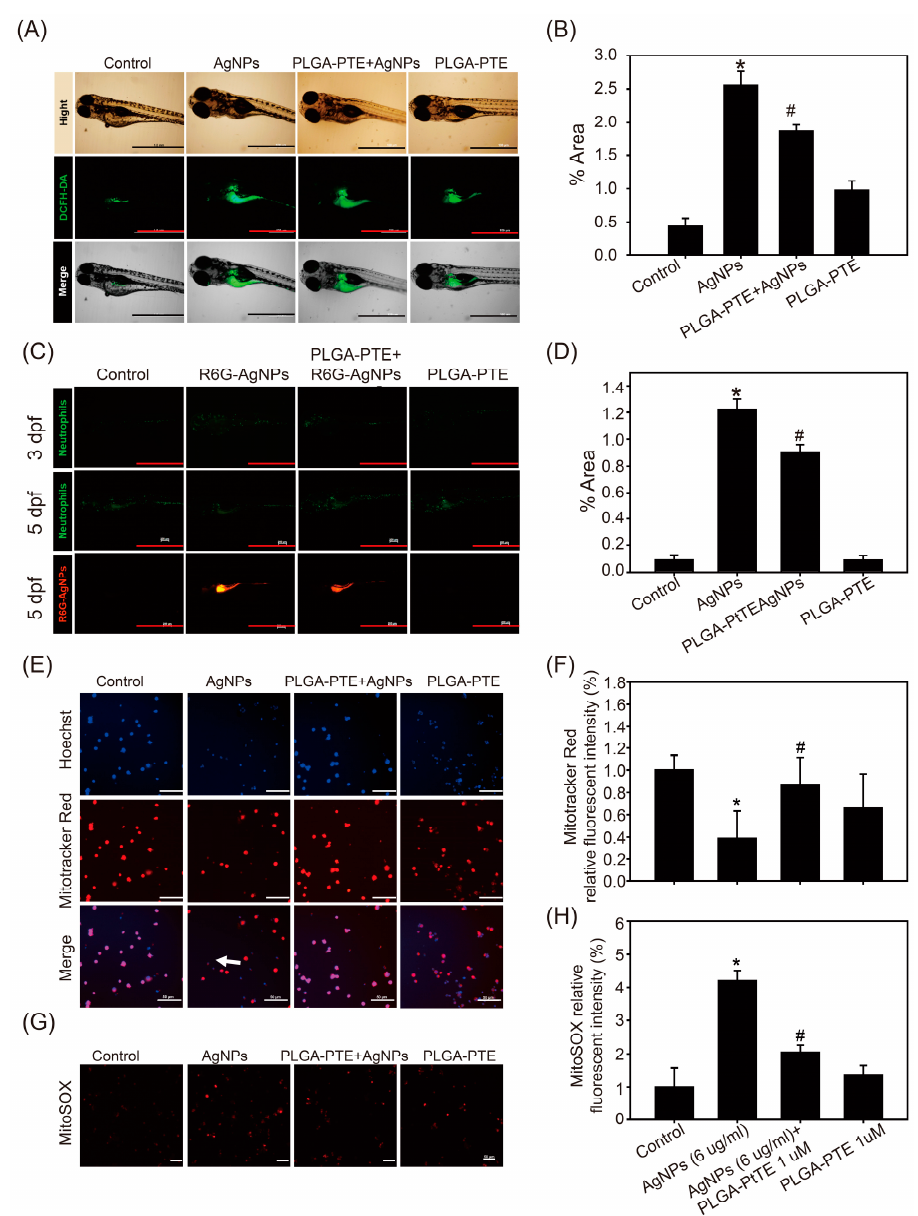
Figure 6. R6G-AgNPs accumulated in zebrafish and affected reactive oxygen species (ROS) production. ( A ) Zebrafish embryos after exposure to control, 0.3 µ g/mL AgNPs, PLGA-PTE + AgNPs, and 0.3 µ g/mL PLGA-PTE for 120 hpf. Then, ROS formation was shown by staining with DCFH-DA fluorescence dye for 30 min. ( C ) R6G-AgNPs were used to determine the content of AgNPs in zebrafish embryos. Scale bar = 1.0 mm.The fluorescence intensity was quantified in ( B , D ). The image presented is representative of three independent experiments ( n = 3). ( E ) Mitochondrial damage was detected by staining with MitoTracker™ Red (loss of mitochondria membrane potential) and ( G ) MitoSOX™ (indicated ROS production) in THP-1 cells after each treatment for 6 h. The white arrow indicated the cells with damaged mitochondria that was lack of staining with Mitotracker. Scale bar= 50 µ m. ( F , H ) The image was quantified and presented as the representative of three independent experiments ( n = 3). * p < 0.05, AgNPs groups versus control groups; # p < 0.05, PLGA-PTE + AgNPs versus AgNPs